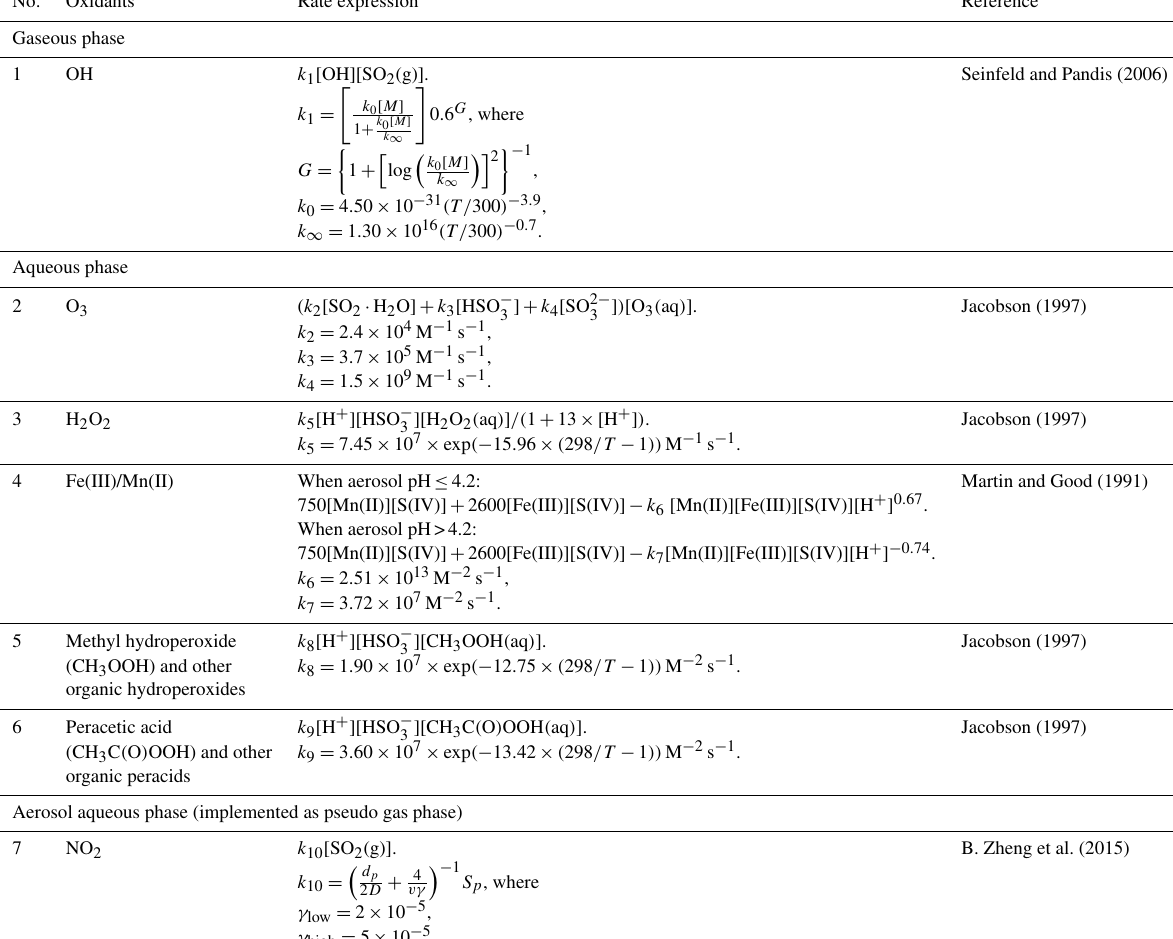
Table 1. Sulfate formation pathways currently implemented in CAMx version 6.40. No.